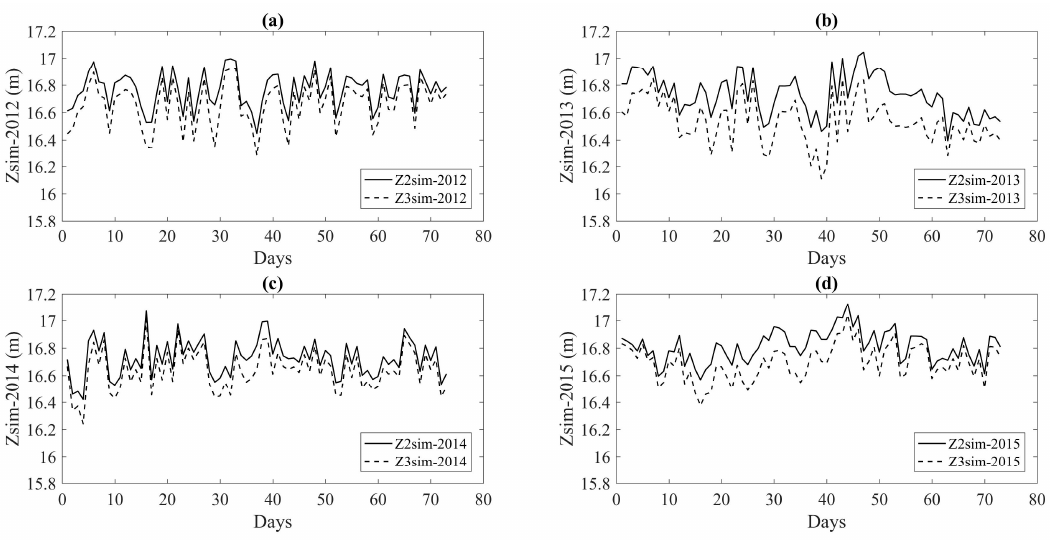
Figure 9. For every year: 2012 ( a ); 2013 ( b ); 2014 ( c ) and 2015 ( d ), the simulated water level values contained in Z2 sim and Z3 sim .